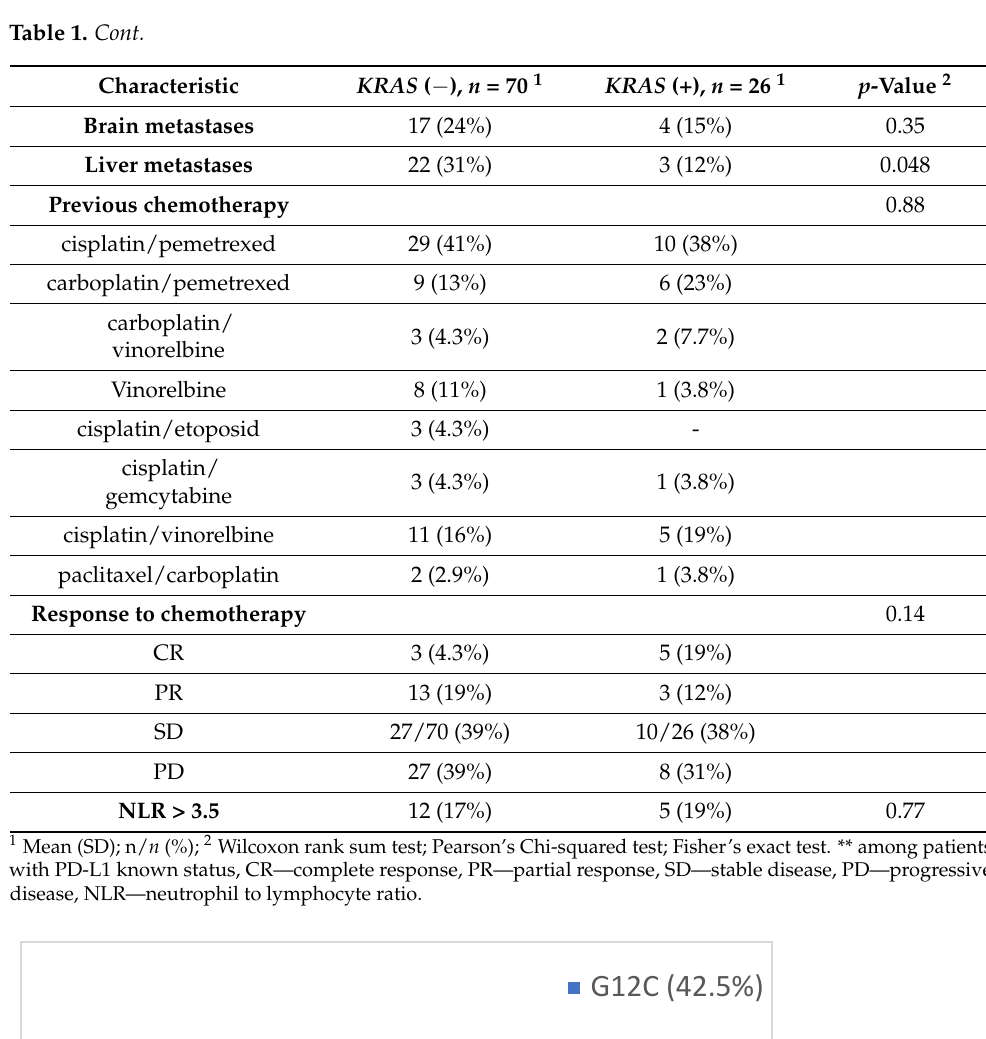
Table 2. Response to treatment by KRAS mutation status. KRAS (-), N = 70